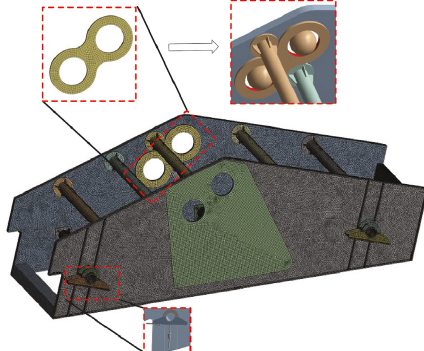
Figure 5: Grid partition of vibrating screen and boundary con- dition